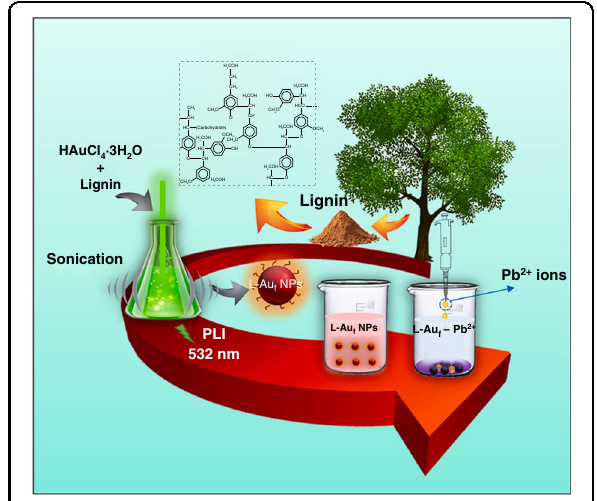
Fig. 13 Schematic design for preparing lignin-mediated Au-NPs using PLI for calorimetric Pd 2 + detection 14 . Copyright (2021)